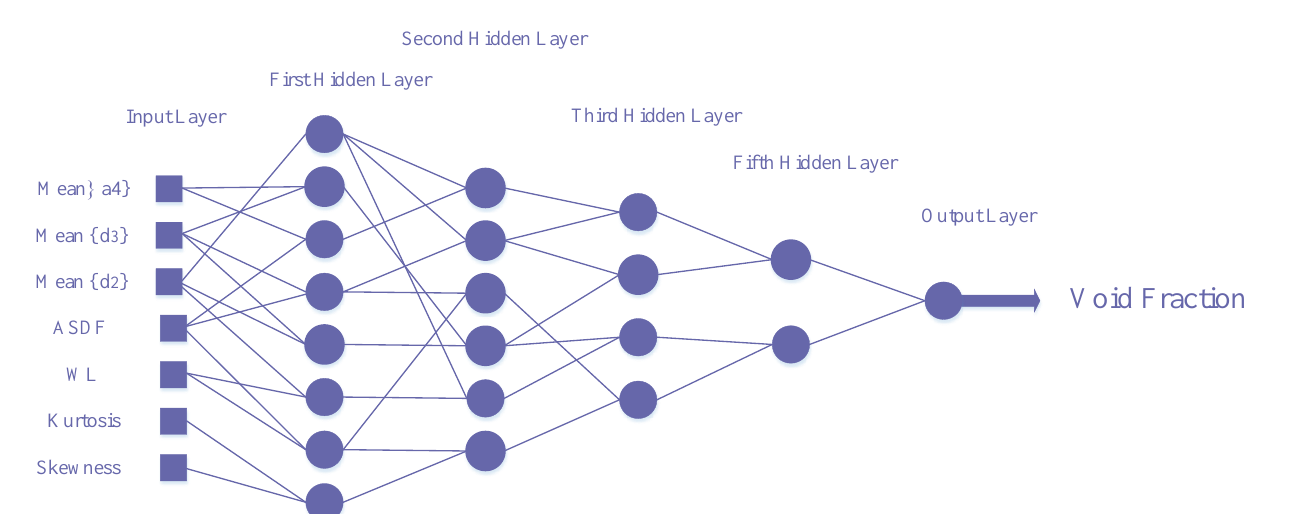
Figure 9. The structure of the trained GMDH neural network.